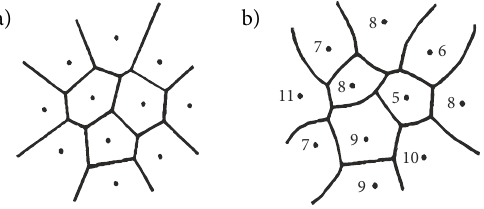
Figure 1. Diagrams: a – regular-Voronoi-diagram; b –